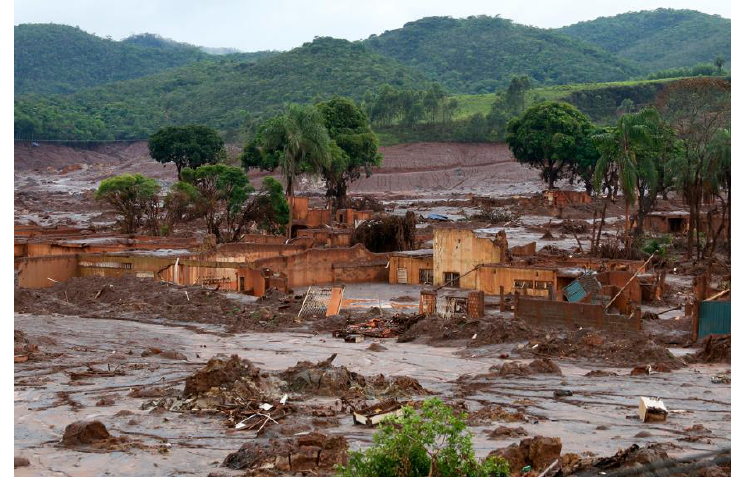
Figure 4. Brumadinho dam disaster, which occurred on 25 January 2019 when Dam I, a tailings dam at the Córrego do Feijão iron ore mine, collapsed.